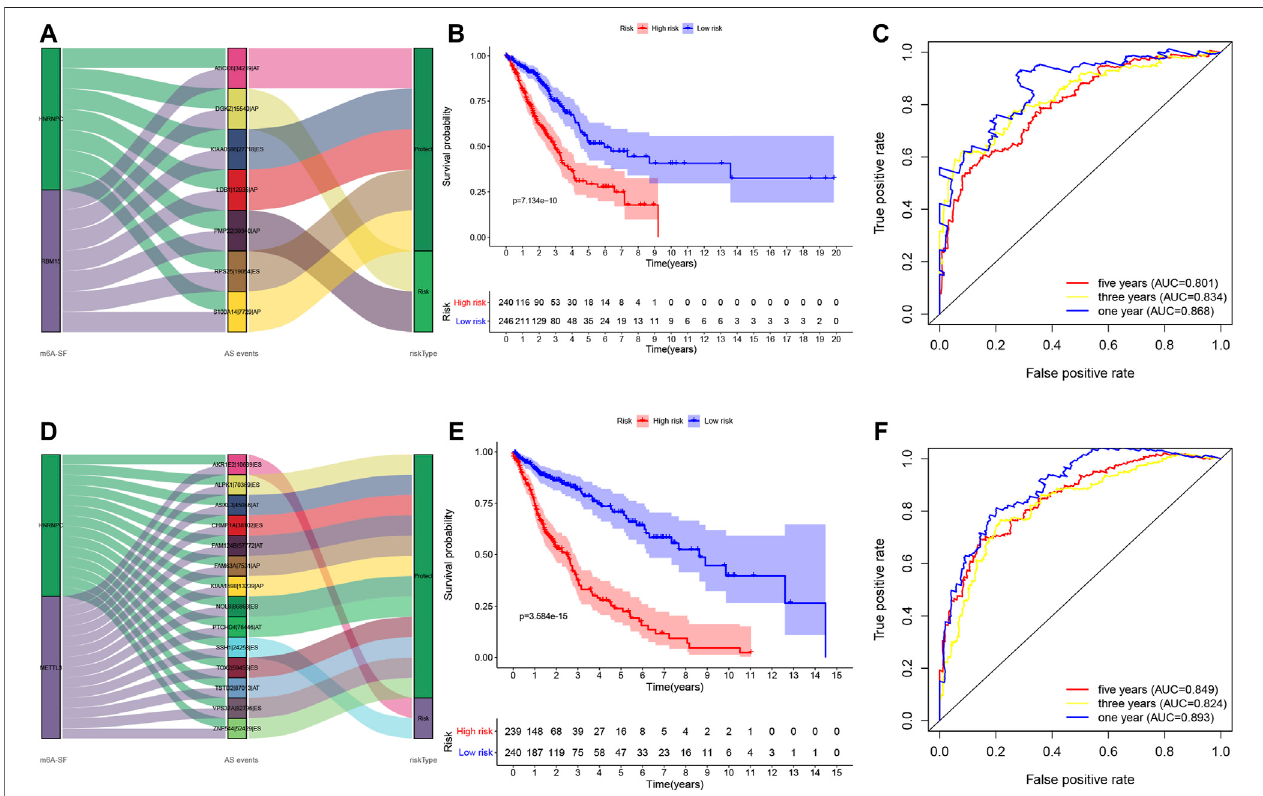
FIGURE 6 | Construction of the prognosis-related AS events signature. (A) The Sankey diagram. The data show the potential prognostic value of the m6A-related prognostic AS events in LUAD. (B) Kaplan – Meier curves strati fi ed by high- and low-risk groups of LUAD. (C) The ROC curves in LUAD. (D) The Sankey diagram. The datashowthepotentialprognosticvalueofthem6A-relatedprognosticASeventsinLUSC. (E) Kaplan – Meiercurvesstrati fi edbyhigh-andlow-riskgroupsofLUSC. (F) The ROC curves in LUSC. LUAD, lung adenocarcinoma; LUSC, lung squamous cell carcinoma; ROC, receiver operating characteristic